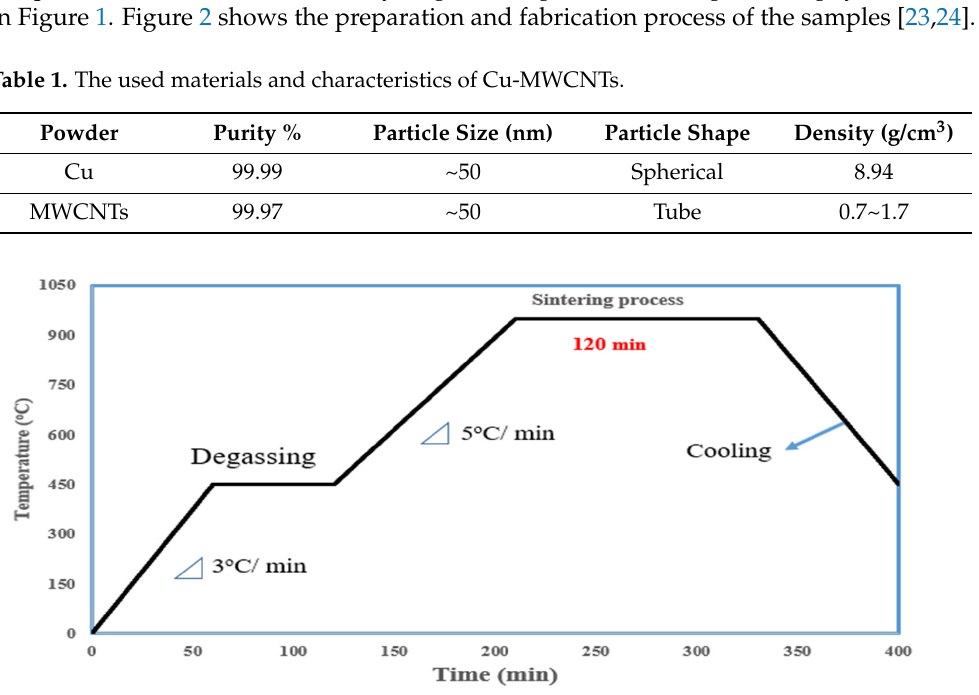
Figure 1. The heating cycle of the sintered sample at 950 °C in hydrogen-inert gas.